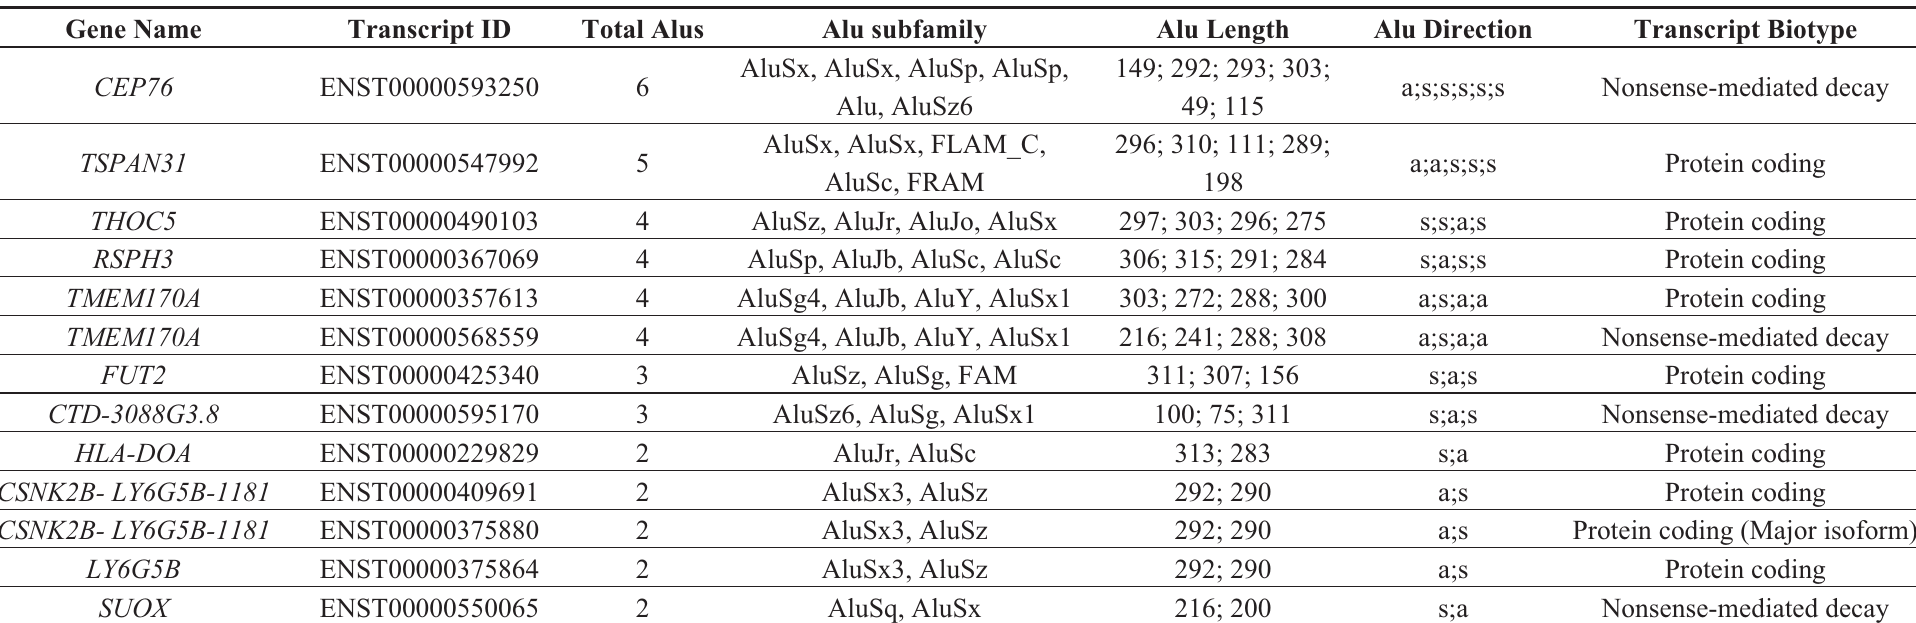
Table 4. IRAlus within the 3'UTRs of T1D genes. The transcripts harboring IRAlus within 3'UTRs are listed with gene name, Ensembl transcript ID, total number of Alus, Alu subfamilies, length of the Alu repeat, and orientation of the Alu element (sense as “s , ” and antisense as “a”). Some of the genes have more than one transcript with